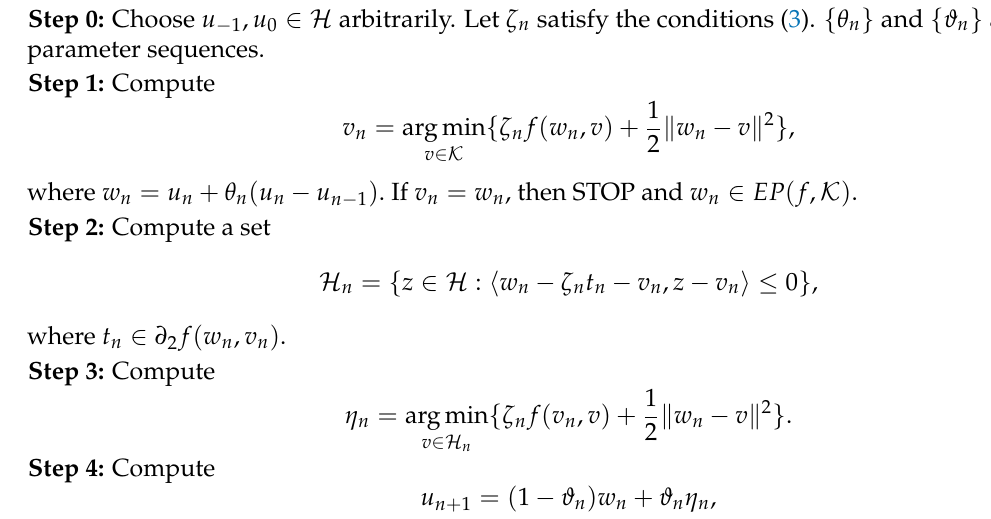
Algorithm 1. Modified subgradient extragradient method for equilibrium